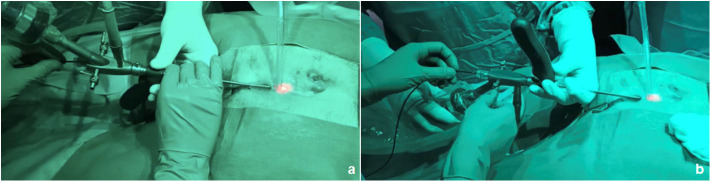
The fistuloscope may be used in normal position (a) or turned 180 degrees down (b) in order to achieve a good view of the fistula's roof.